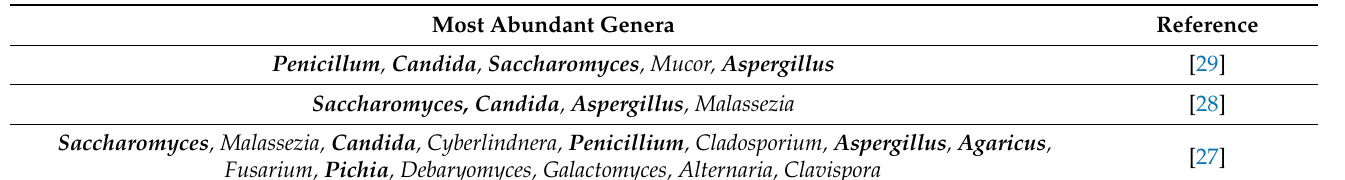
Table 2. Most abundant genera in mycobiome studies. In bold overlap with genera found in this study. Most Abundant